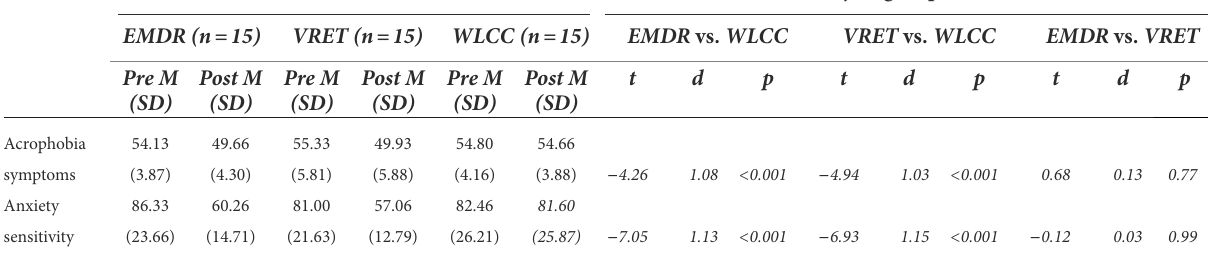
TABLE 3 Means and standard deviations for the acrophobia symptoms and anxiety sensitivity at pre and post treatment by condition and between- condition comparisons.